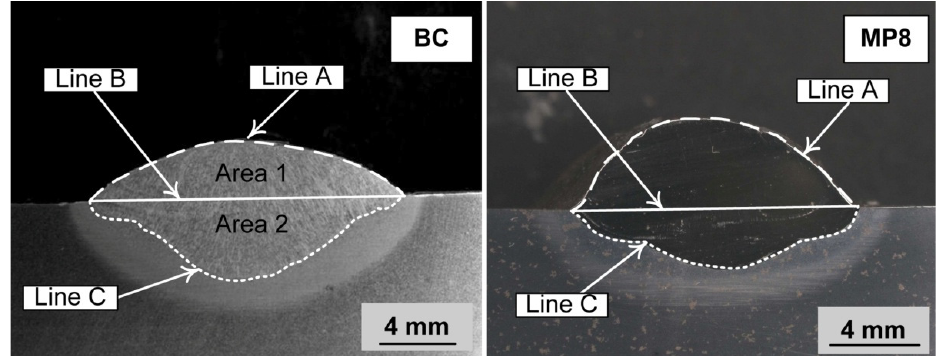
Figure 2. Stereoscope micrographs of the weld metal cross-sections.